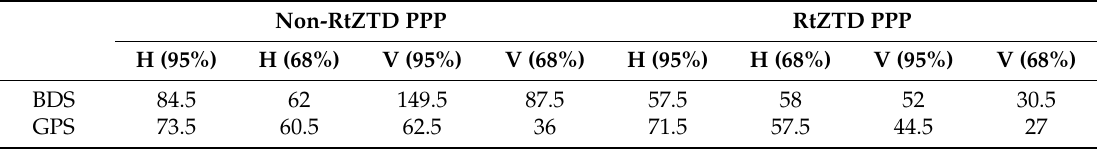
Table 7. Convergence time comparisons of non-RtZTD and RtZTD PPP (unit: min)